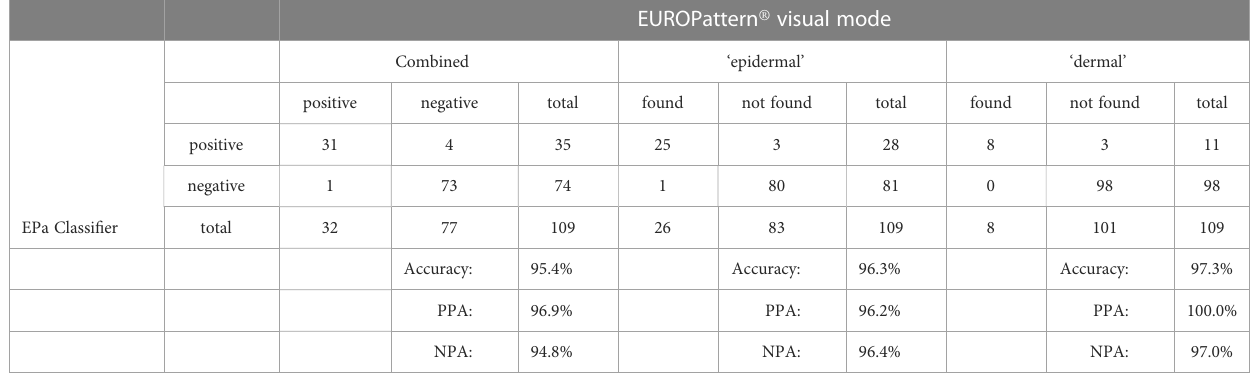
TABLE 1 Performance of the salt-split skin classi fi er (EPa-Classi fi er) compared to the conventional evaluation by an IIF